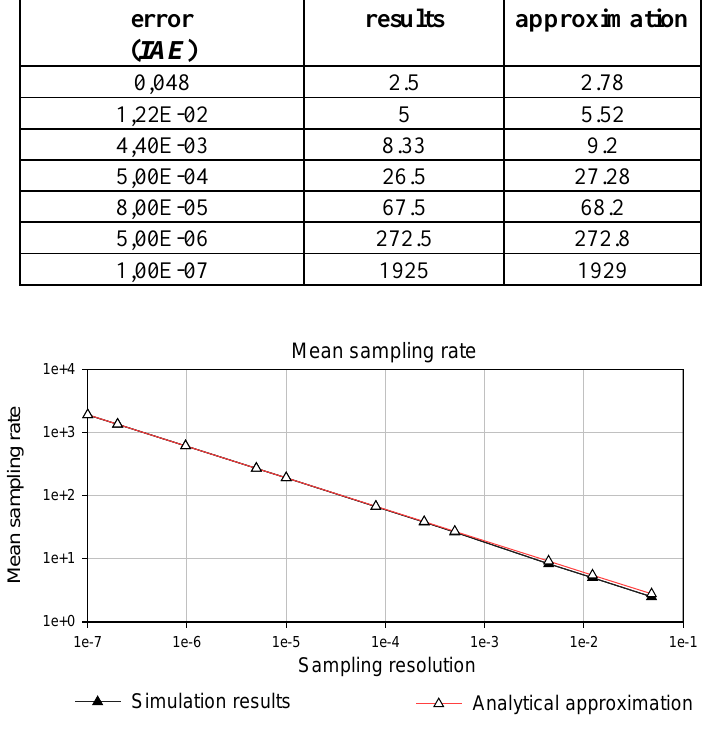
Figure 6. Simulation results versus analytical approximation of the mean sampling rate according to the integral